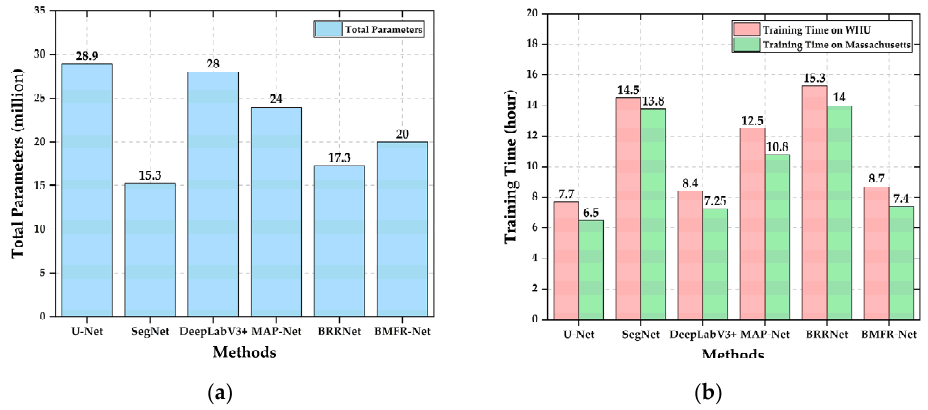
Figure 14. Comparison chart of different methods: ( a ) comparison chart of total parameters; ( b ) comparison chart of training time.